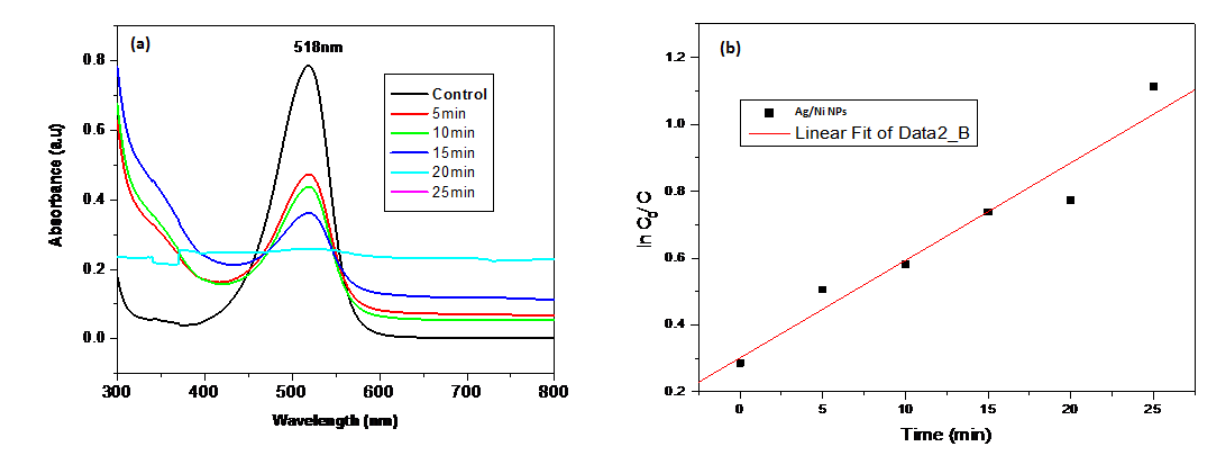
Figure 6: (a) UV-Visible absorption spectrum of safranin O textile dye degradation in absence and presence of silver/nickel bi-metallic nanoparticles using photocatalysis method; (b) Kinetic plot of safranin O textile dye